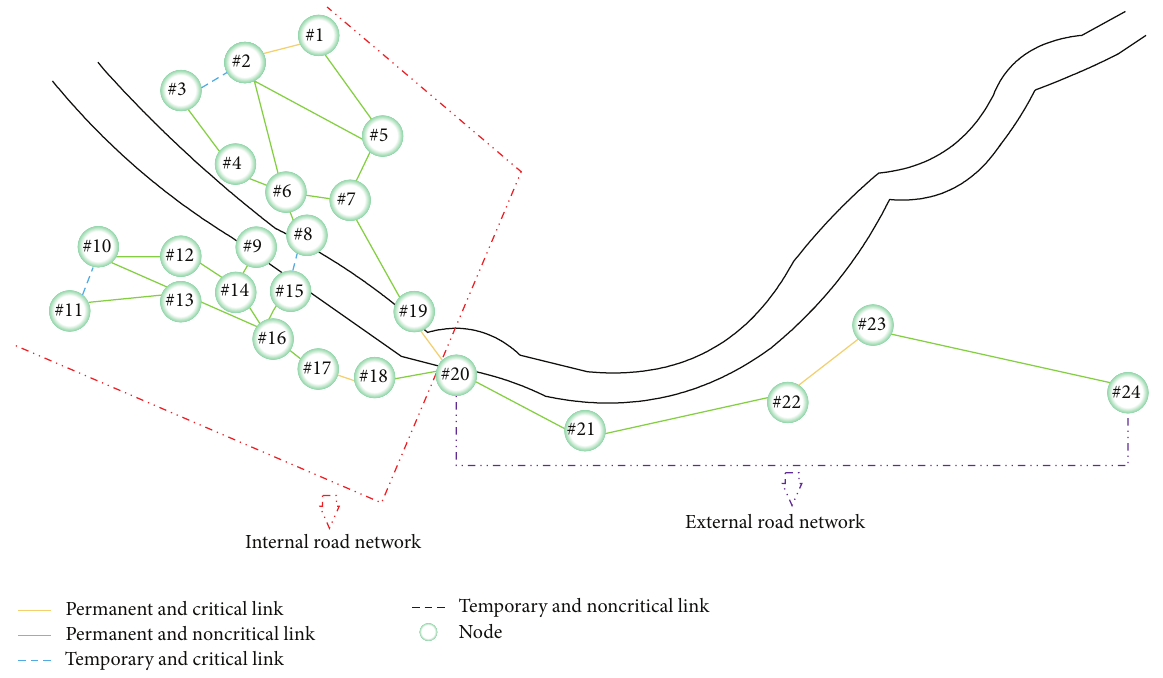
Figure 7: Simplified transportation network illustration in XLD hydropower LSCP.